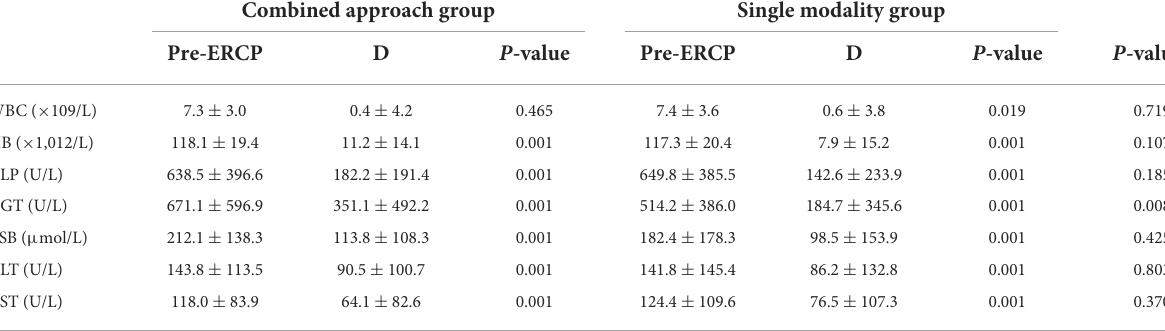
TABLE 4 Laboratory parameters in the combined approach group and the single modality group.